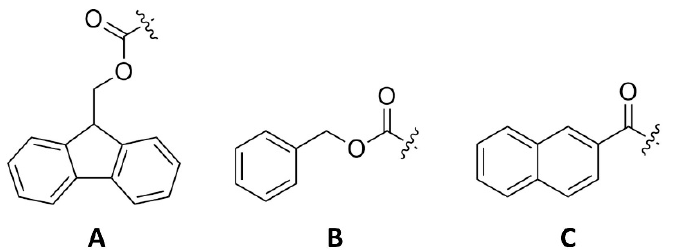
Figure 2. Examples of N ‐ terminal aromatic capping groups of peptide hydrogelators: ( A ) Fluorenyl ‐ methoxycarbonyl (Fmoc); ( B ) benzyloxycarbonyl (Cbz); ( C ) 2 ‐ naphthoyl.